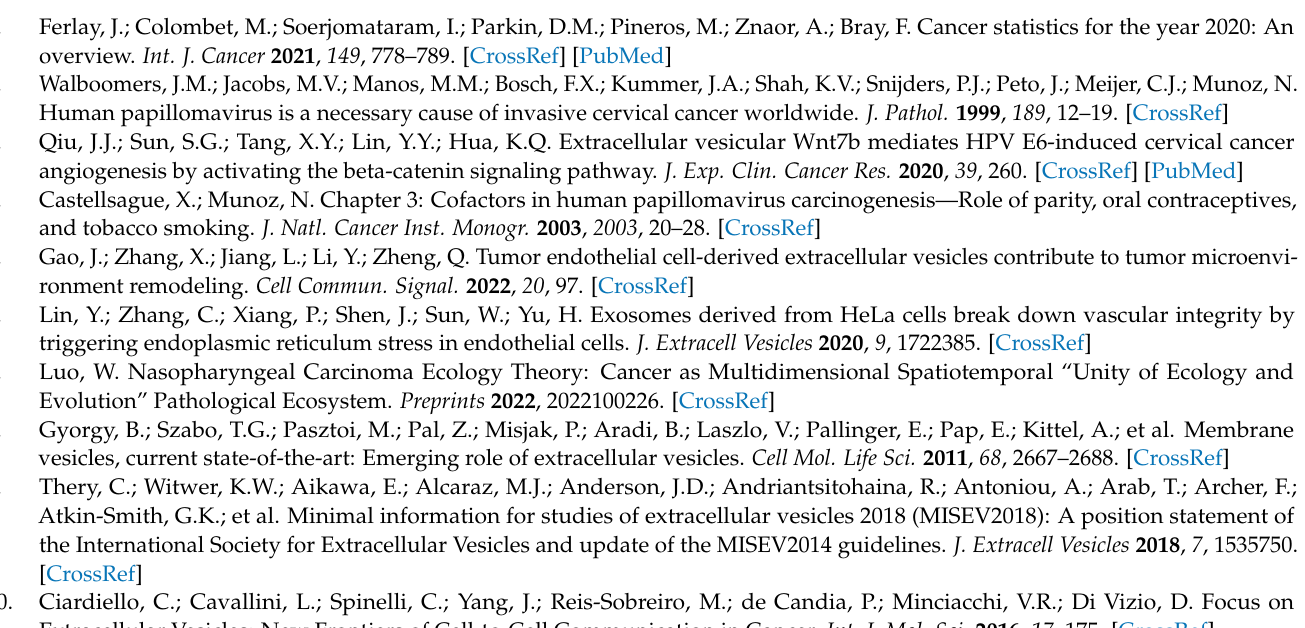
blot; Table S1: Identified proteins; Table S2: Analysis in Vesiclepedia; Table S3: Top 100 proteins Vesiclepedia; Table S4: Up- and downregulated proteins; Table S5: Identification via qualitative proteomic analysis; Table S6: Gene ontology of up- and downregulated proteins; Table S7: Reactome biological